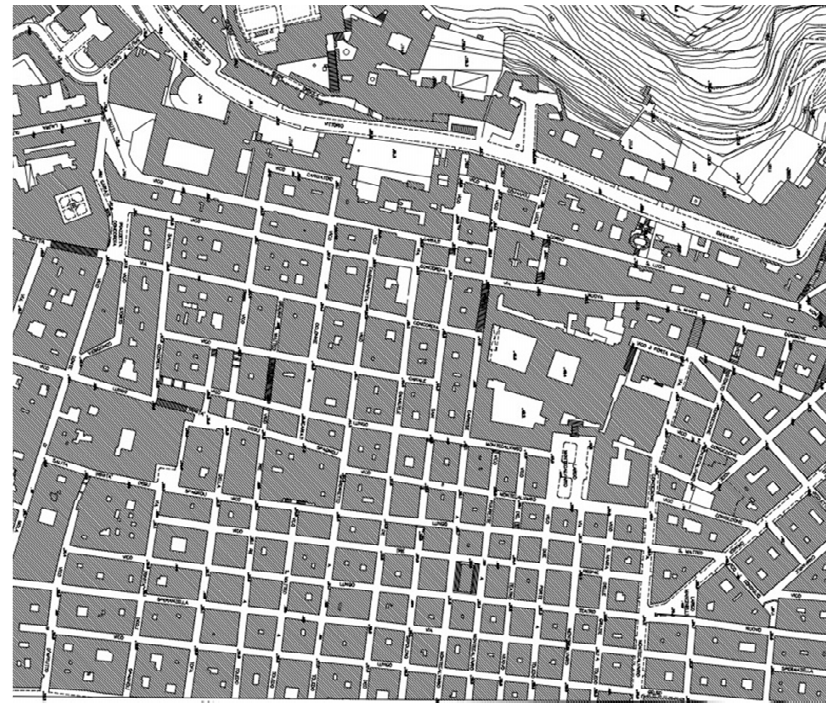
Figure 1. Map of the Quartieri Spagnoli. The area dates back to around 1533–1536 (Theerapappisit 2012); the image shows the maze-like urban structure composed of alleys. (Modified from www.iconografiacittaeuropea.unina.it, accessed on 25 May 2021).